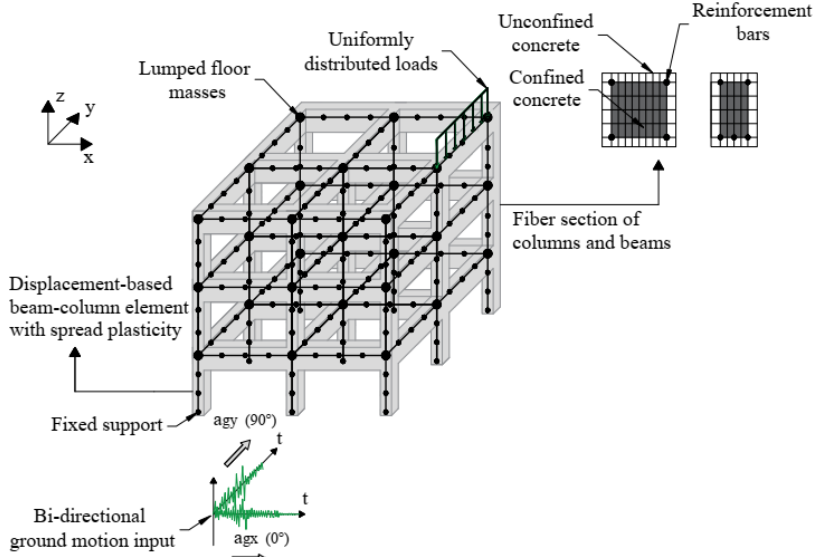
Figure 3. Summary of numerical model: elements, fiber cross-section, vertical loads, masses, and bi-directional ground motion input.